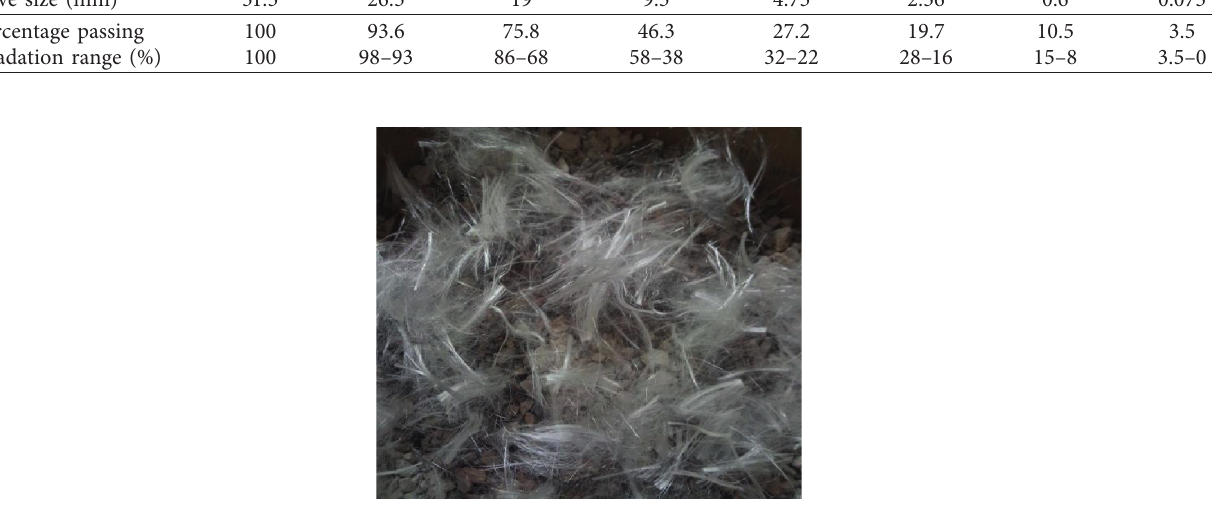
Figure 1: PVA fiber.